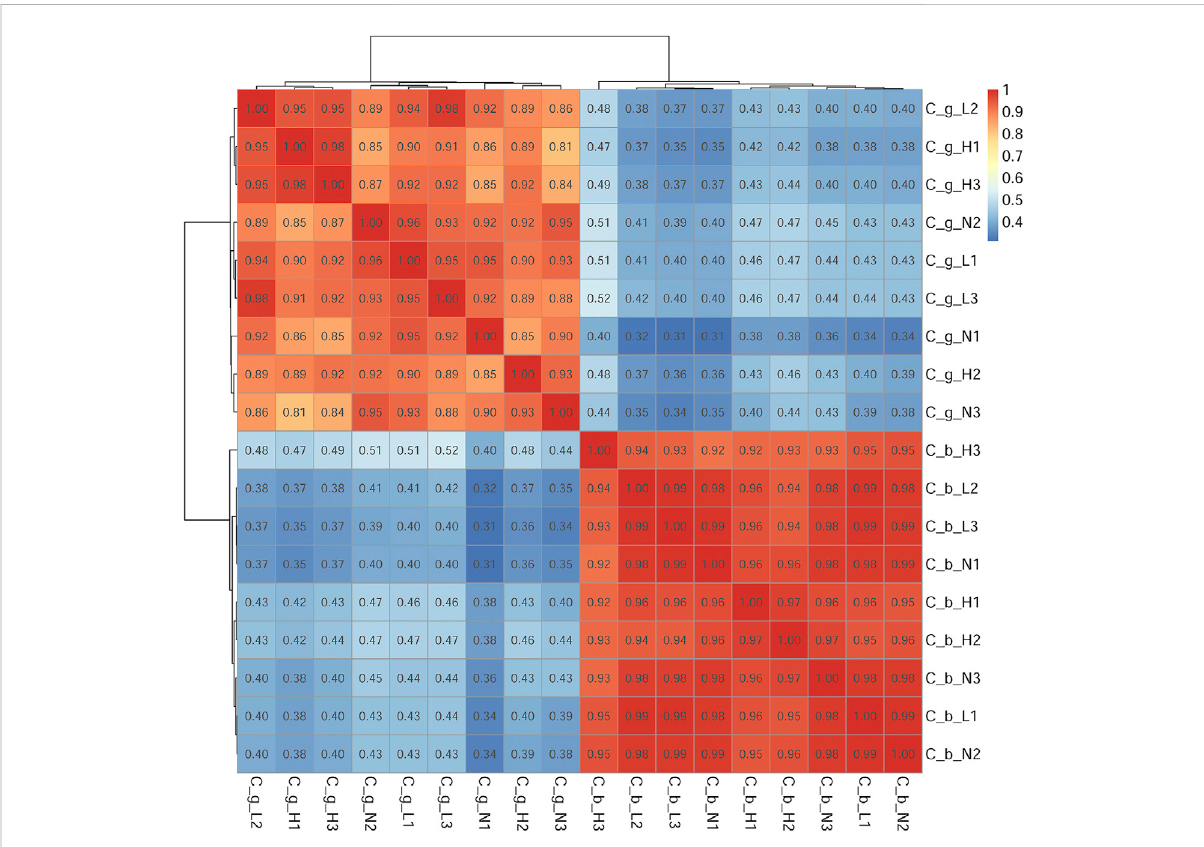
FIGURE 2 Samples correlation test. Note: C_b_N1, C_b_N2 and C_b_N3 represent brain tissues at 22 ° C, C_b_L1, C_b_L2 and C_b_L3 represent brain tissues at 4 ° C, C_b_H1, C_b_H2 and C_b_H3 represent brain tissues at 30 ° C; C_g_N1, C_g_N2 and C_g_N3 represent gill tissues at 22 ° C, C_g_L1, C_g_L2 and C_g_L3 represent gill tissues at 4 ° C, C_g_H1, C_g_H2 and C_g_H3 represent gill tissues at 30 ° C. Deeper red represents the higher the correlation, deeper blue represents the lower the correlation. The range of correlation coef fi cient was 0.8 – 1, indicating that the correlation among samples were very strong, which below 0.8, indicating that the correlation among samples were low.